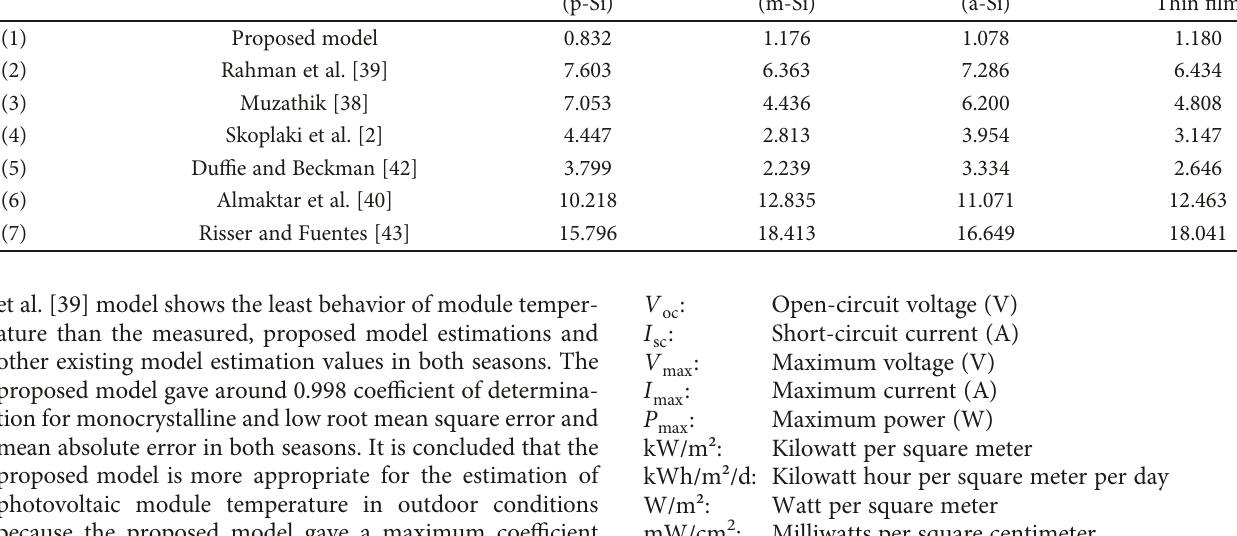
Table 11: Mean absolute error (MAE) of each PV module in summer. S.